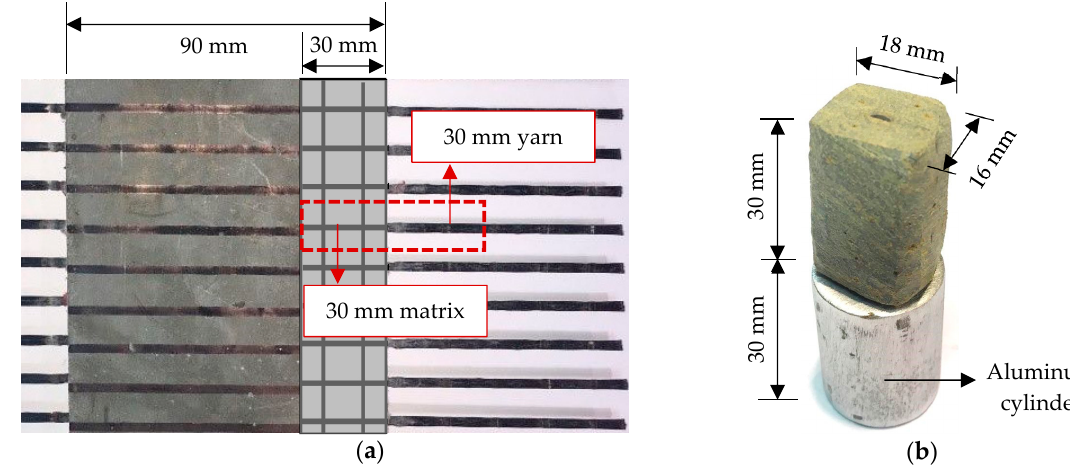
Figure 4. Specimen production for single-yarn pullout tests: ( a ) cutting configuration; ( b ) final specimen dimensions and fixities.